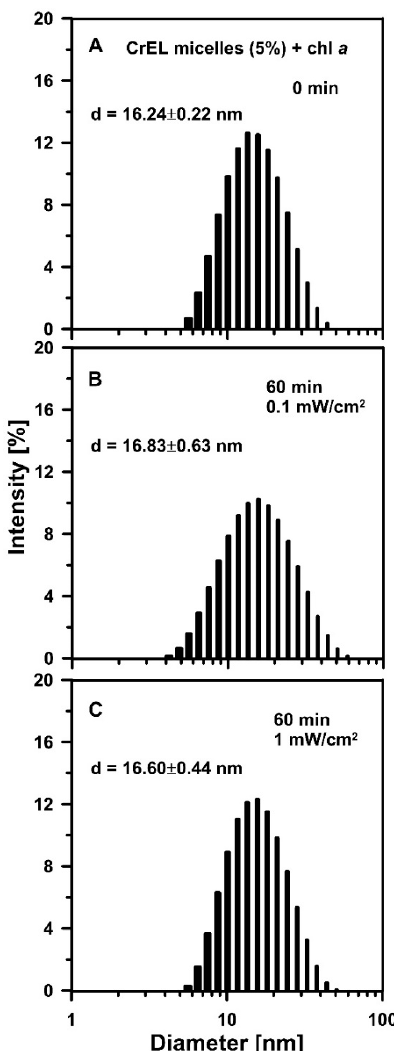
Figure 4. Cremophor micelles size distribution histograms. ( A ): An amount of 5 wt% Cremophor nano-emulsion mixed with chl a at the molar concentration of 10 − 5 M (CrEL micelles (5%) + chl a ). The histogram was measured directly after the sample preparation (0 min). ( B ): The CrEL nano-micelles with chl a illuminated with white light for 60 min. The light power was 0.1 mW/cm 2 . ( C ): The CrEL nano-micelles with chl a illuminated with white light for 60 min. The light power was 1 mW/cm 2 . Histograms were obtained using the dynamic light scattering method. The representative sizes of nano-micelles are included in the figure (obtained from the presented histograms, numbers represent the mean values obtained by the replicate measurements of the same sample, n = 3 technical replicates). The experiment was repeated three times (biological